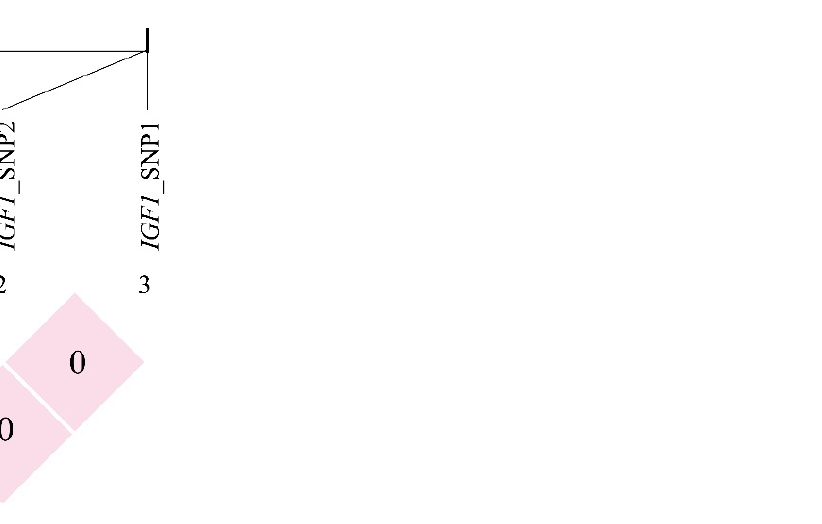
Figure 5. Linkage disequilibrium plot ( r 2 ) and haplotype blocks for SNPs of the IGF1R gene in Hulun 74 Buir sheep. The values in boxes are pairwise SNP correlations ( r 2 ); dark red boxes indicate strong LD 75 ( r 2 > 0.33) and light red boxes without numbers represent very weak LD ( r 2 < 0.001).